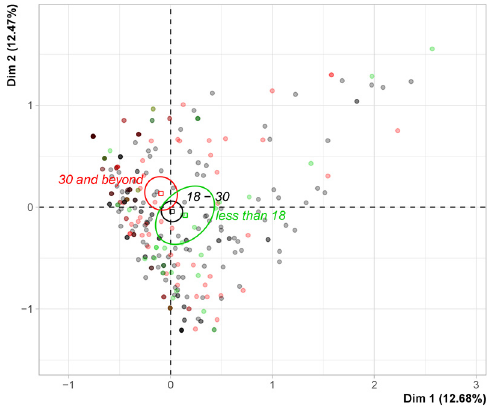
Figure A10. MCA. Distribution of respondents by age.